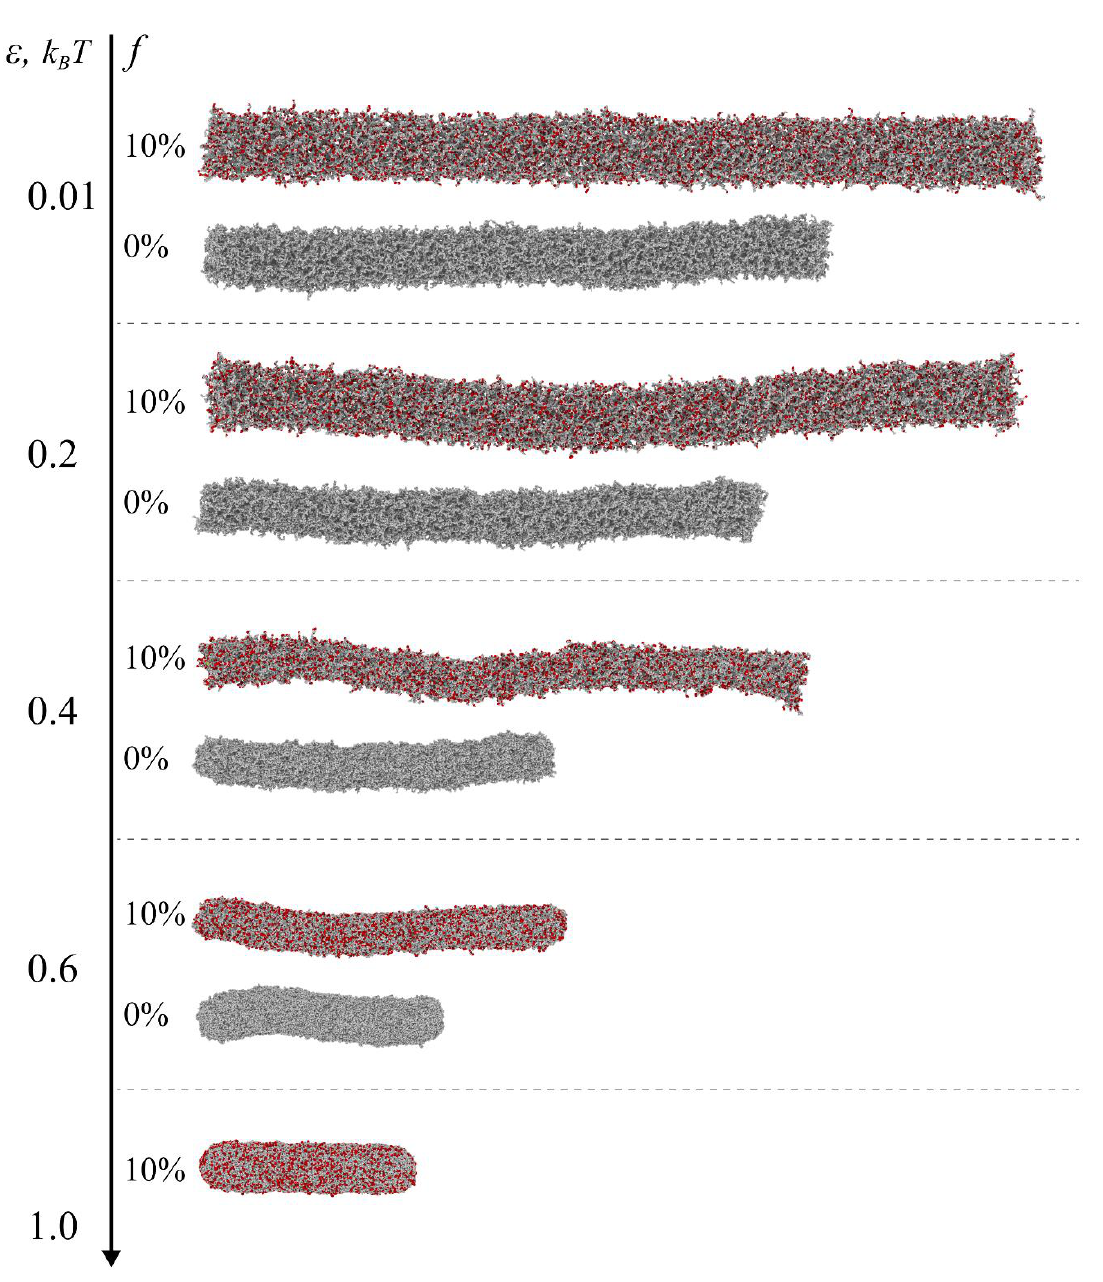
Figure 3. Side-view snapshots of equivalent neutral ( f = 0%) and charged ( f = 10%) microgels upon solvent quality decline. The charged groups were slightly enlarged for clarity. The molecular weight and subchain length of the microgel are N = 100,000 and M = 10, respectively. The initial aspect ratio of the microgels is A = 10.